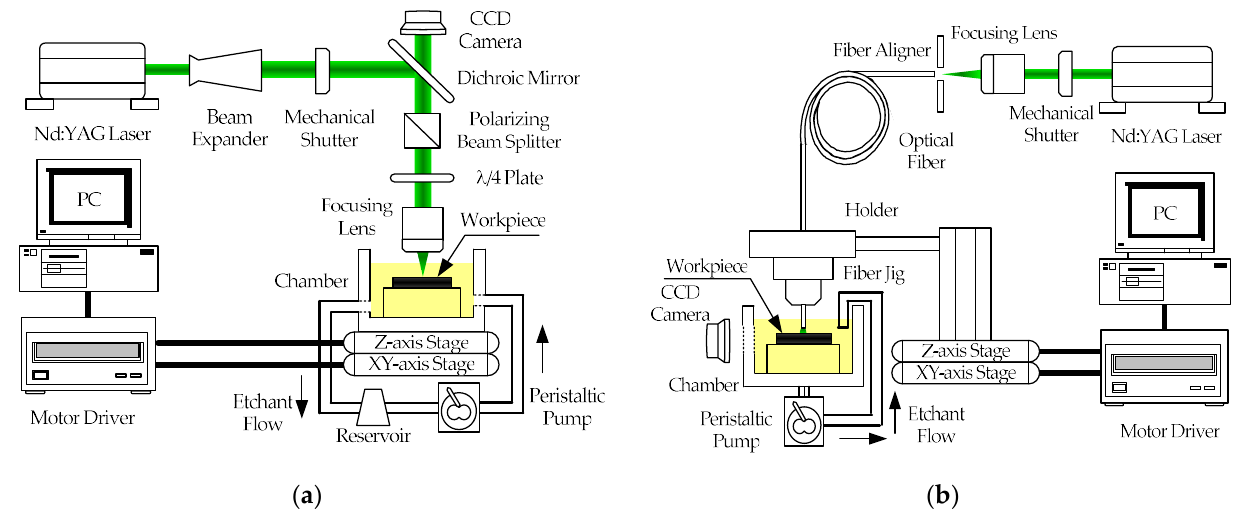
Figure 1. Schematic diagram of the ( a ) conventional lens-based LIE setup and ( b ) optical fiber-based LIE setup.